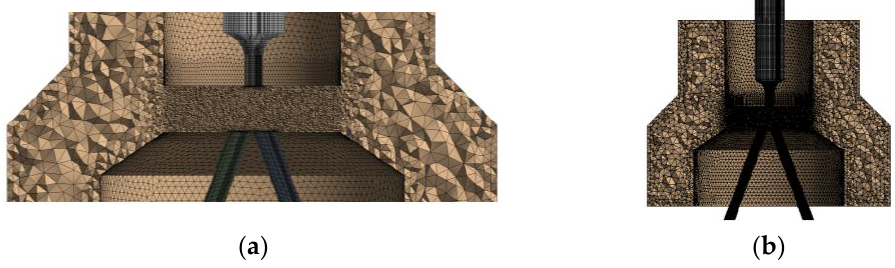
Figure 10. Grid model diagram: ( a ) partial encryption; and ( b ) the whole grid.